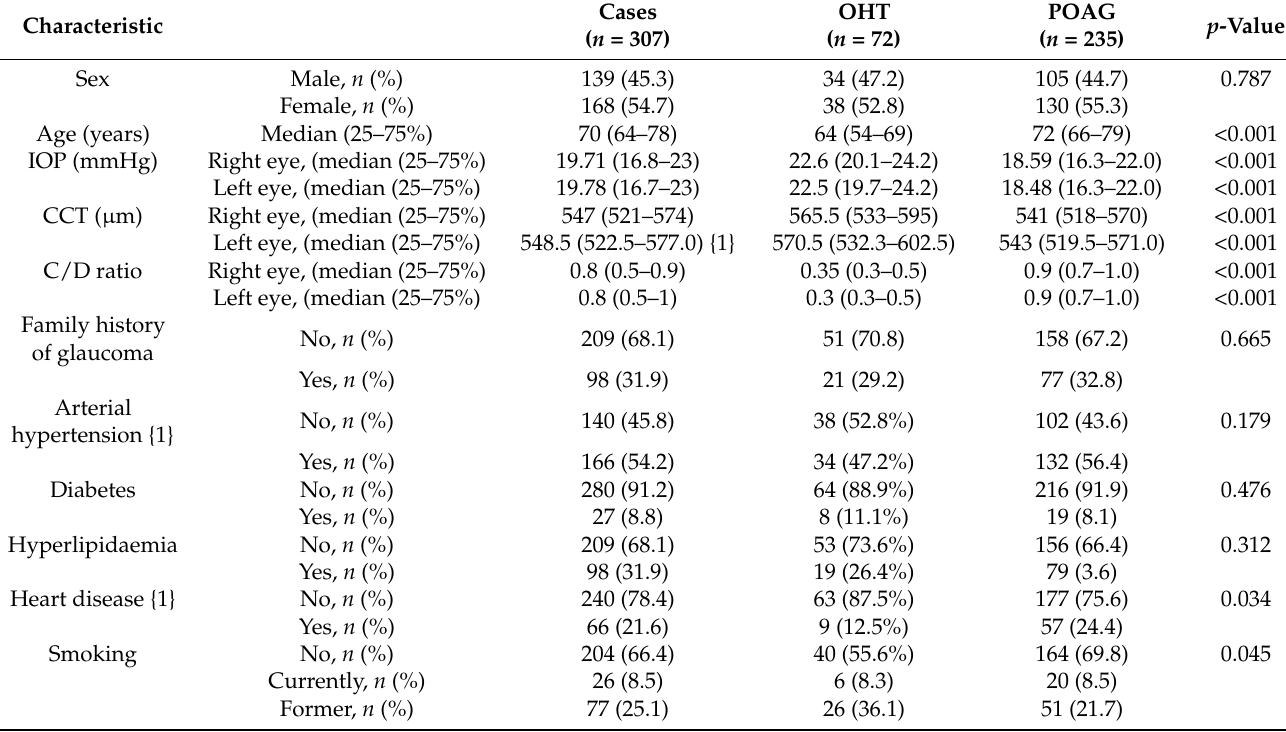
Table 1. Clinical characteristics of